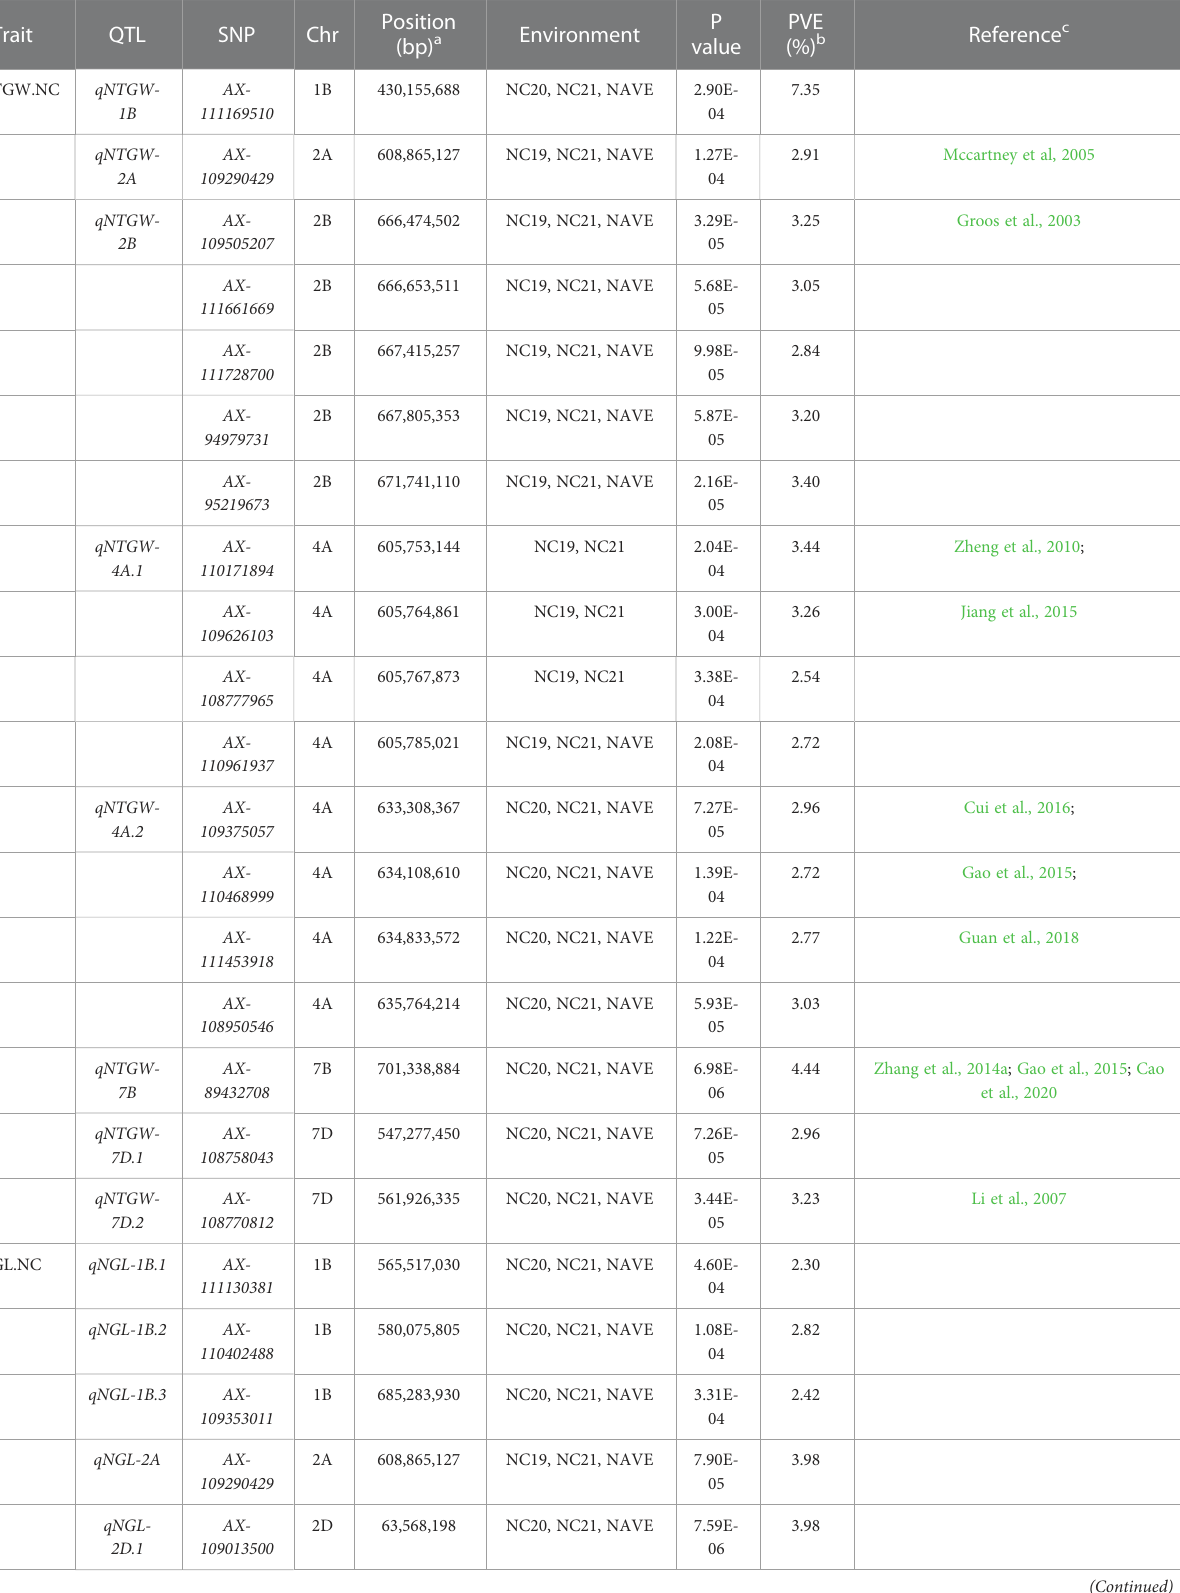
TABLE 2 The QTL and signi fi cant SNPs identi fi ed by GWAS for the yield-related traits under normal (NC) conditions.